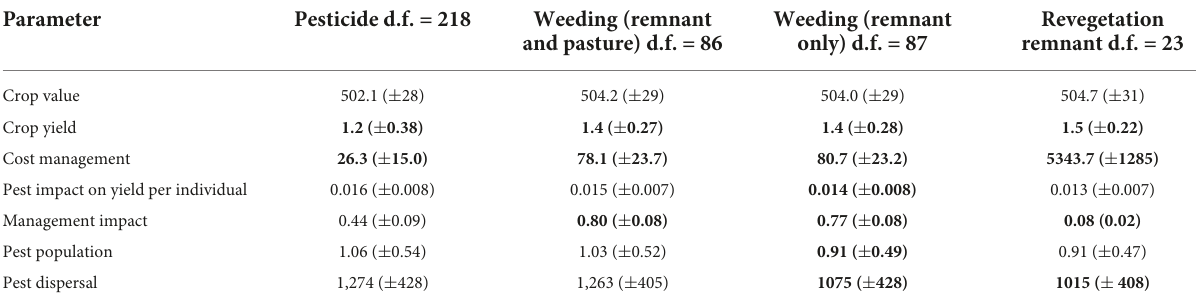
TABLE 3 Mean values (and standard deviation) of each variable for scenarios that achieved a gross cumulative profit at year